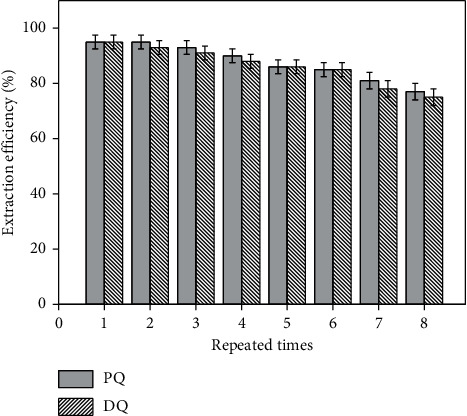
Reusability tests of CoFe2O4@SiO2 MNPs for the extraction efficiency toward PQ/DQ.